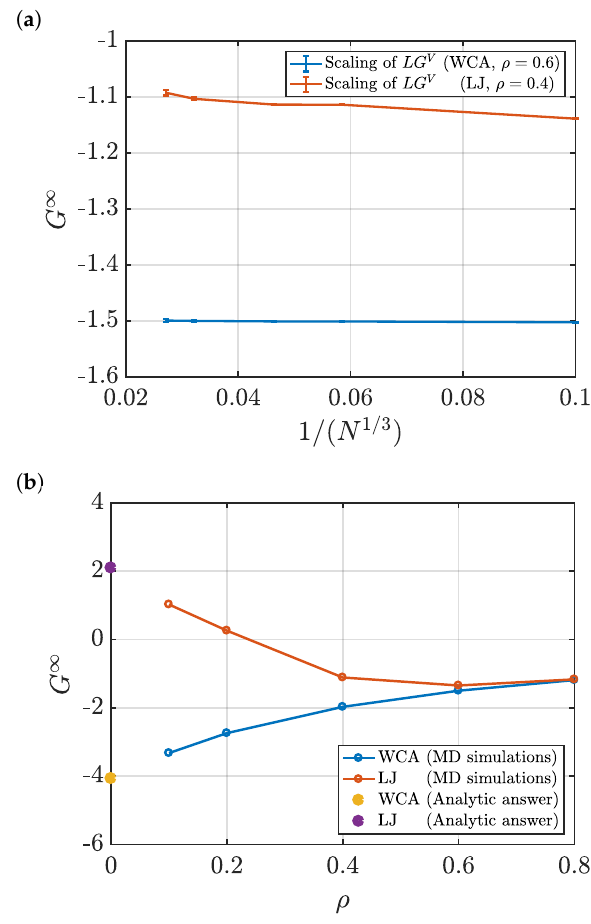
Figure 9. ( a ) KB integrals in the thermodynamic limit G ∞ as a function of the size of the system for the WCA fluid at ρ = 0.6, and the LJ fluid at ρ = 0.4. Both fluids are simulated at T = 2 (dimensionless units). ( b ) G ∞ as a function of dimensionless density ρ of LJ and WCA systems at T = 2. For all densities, the same number of particles is used, N =